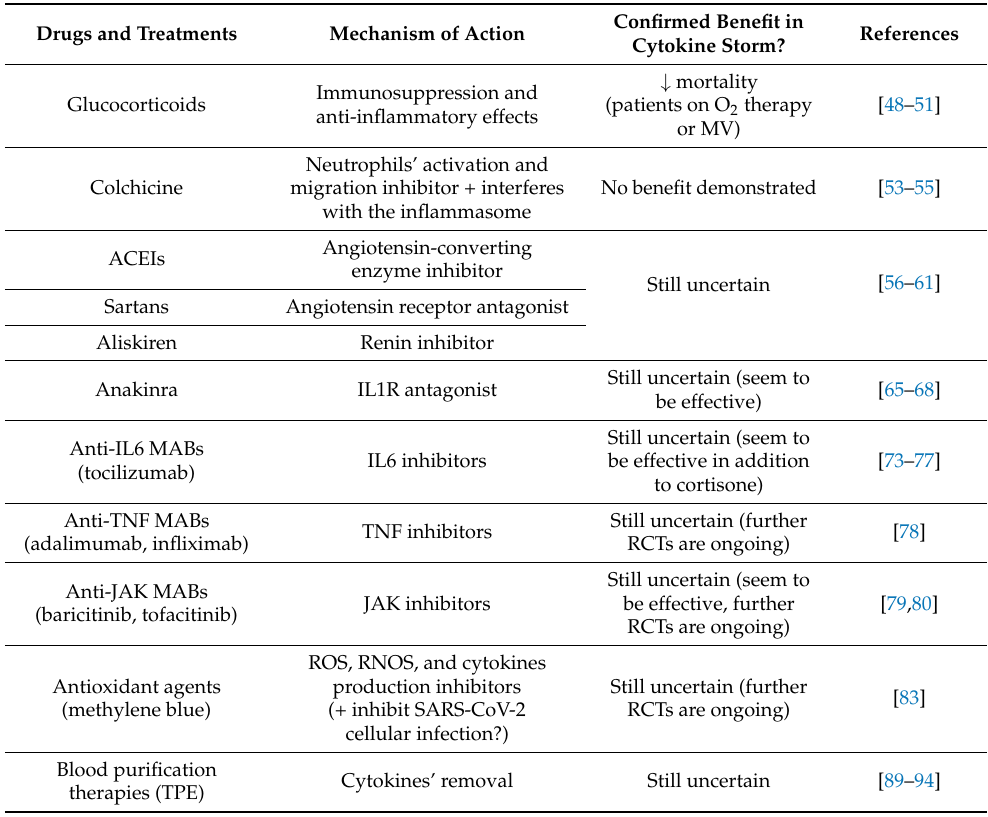
Table 2. A summary of the main drugs and treatments which may be used in the course of the cytokine storm in COVID-19. Abbreviations and symbols: ACEIs, angiotensin-converting enzyme inhibitors; MABs, monoclonal antibodies; MV, mechanical ventilation; TPE, therapeutic plasma exchange ↓ , decreased; +,